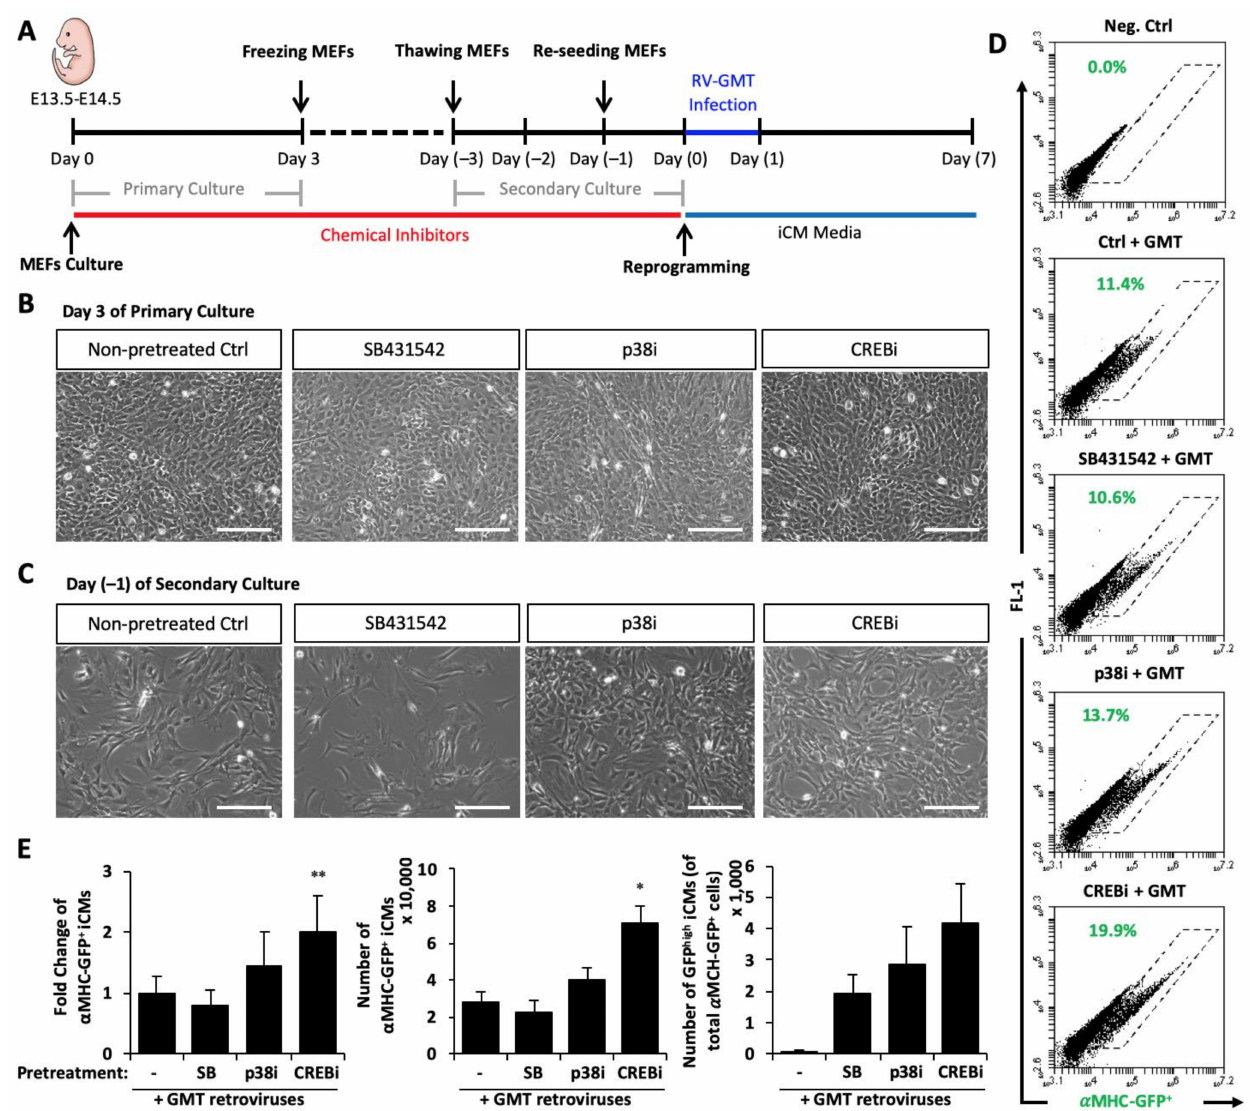
Figure 6. Pretreatment of MEFs with CREB-CBP inhibitor preserves cellular plasticity for reprogramming. ( A ) Experimental design of MEF culture and pretreatments of TGF β inhibitor (SB431542), p38 inhibitor (p38i), or CREB inhibitor (CREBi) before direct cardiac reprogramming by GMT retrovirus. ( B ) Representative images of compound-treated MEFs at Day 3 of primary culture. ( C ) Representative images of MEFs at Day ( − 1) of secondary culture. ( D ) Representative FACS plots of α MHC-GFP + iCMs reprogrammed from MEFs with or w/o pretreatments of chemical compounds. ( E ) Average fold changes of the percentage (left panel) and absolute number (middle panel) of α MHC-GFP + iCMs, and average number of GFP high population among total α MHC-GFP + iCMs (right panel) from MEFs pretreated with SB431542, p38i or CREBi. MEFs without pre-treatment of the same-batch culture were used as the ctrl group. * p < 0.05 or ** p < 0.01 vs. non-pretreated ctrl. Bars indicate 50 µ